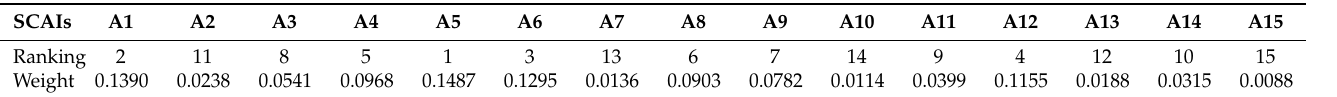
Table A6. Standardized SCAIs weight